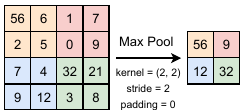
Figure 1: Example of Max Pool- ing